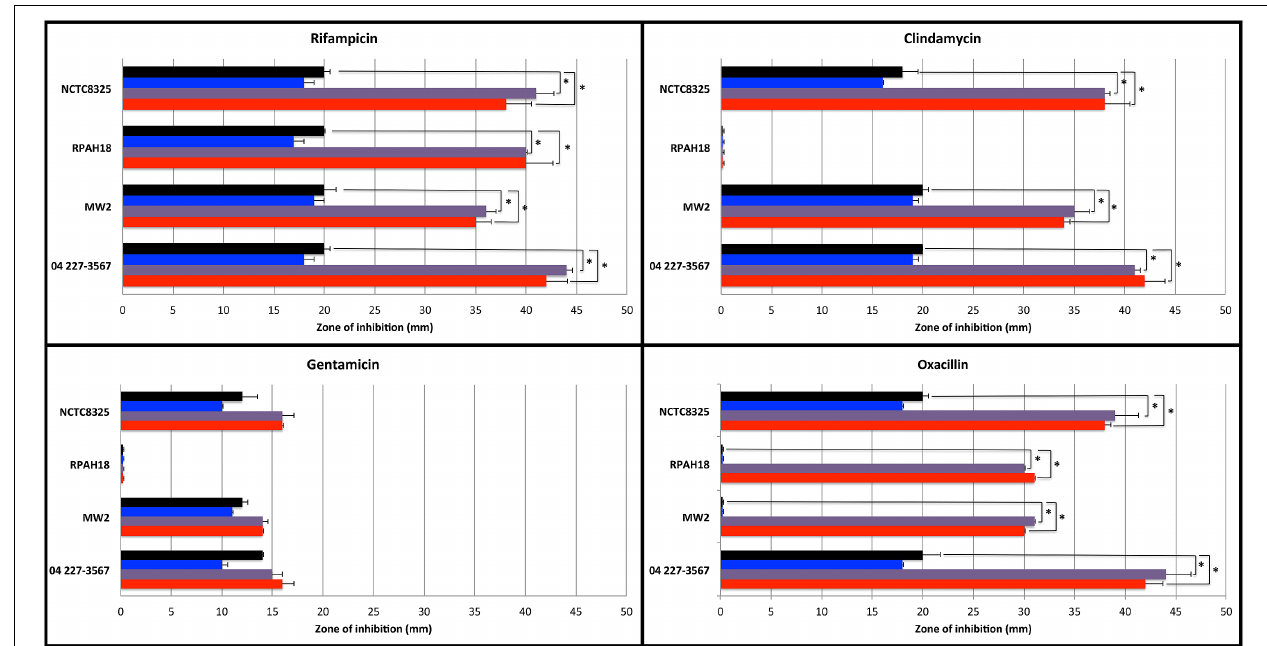
bar), or 5% Medihoney (red bar). Mean values are presented and error bars indicate one SD. Asterisks above the honey-antibiotic combination treatments indicate statistically significant differences from the antibiotic treatment alone, as determined by ANOVA analysis with a post hoc Dunnett’s test. Data for rifampicin (top left) is copied with permission from Müller etal. (2013).